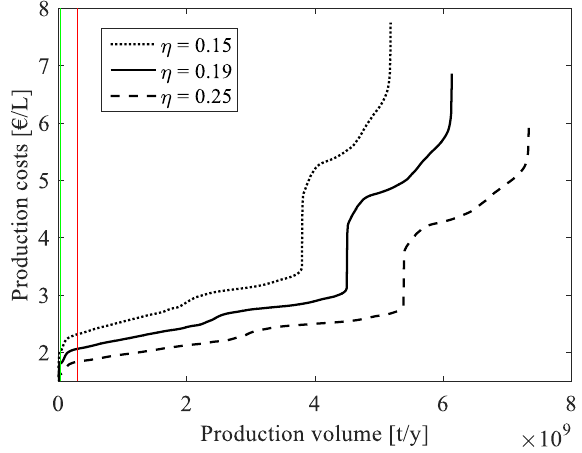
Figure A1. The cost-supply curve of solar thermochemical jet fuel for the MED region with current jet fuel demand in the selected countries [94] ( green line ) and world jet fuel demand [92] ( red line ).